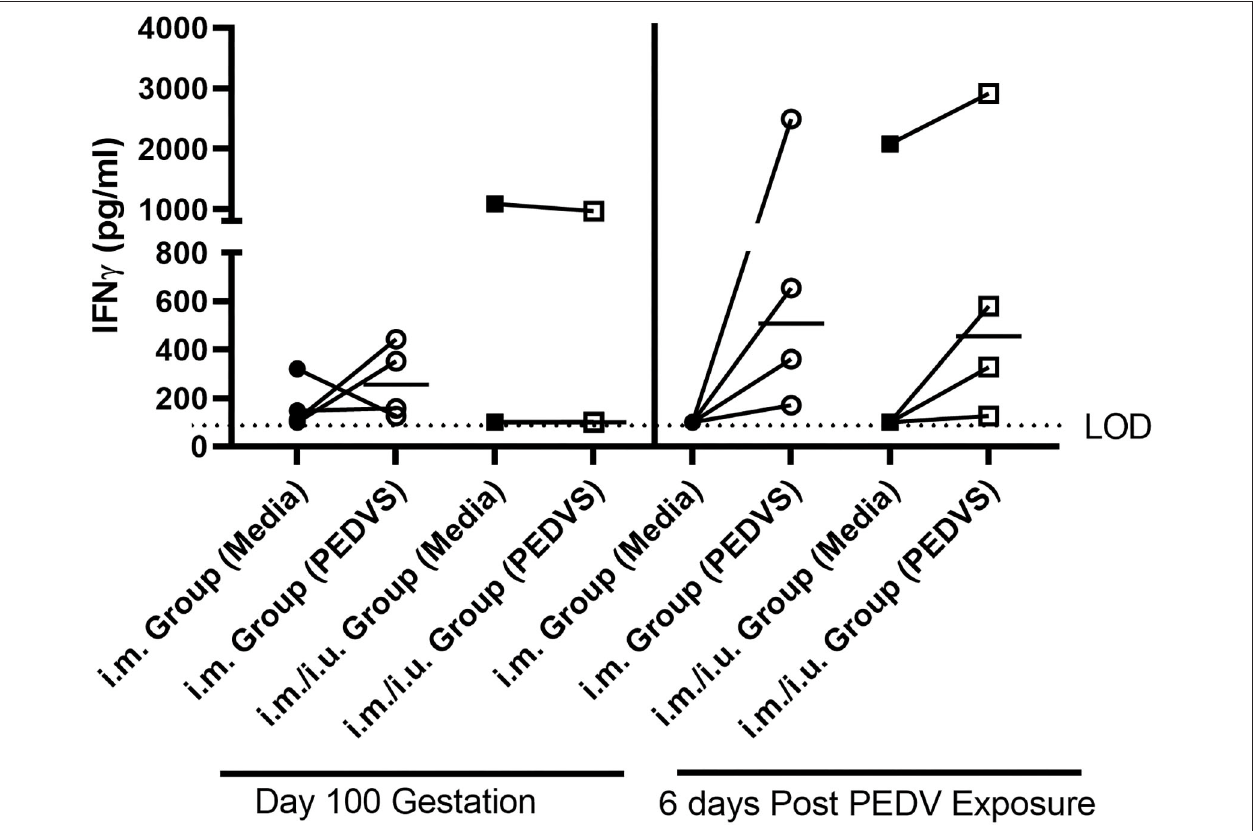
FIGURE 2 | Cell-mediated immune responses quantified by gilts vaccinated with a single i.m vaccine or a i.m vaccine primed with an i.u. vaccine at breeding. IFN γ production was established using a cytokine ELISA kit. PBMCs were isolated on day 100 gestation and on day 9 after farrowing, which is 6 days post indirect exposure to PEDV. Each symbol represents one animal. ELISAs were conducted in Immulon 2U plates and were read using the SpectraMax plus microplate reader and the limit of detection (LOD) is 100 pg/ml. Cytokine titers were graphed in GraphPad Prism 9. The median value is denoted by a horizontal bar and statistical comparisons made to unstimulated cells and cells stimulated with recombinant PEDVS1 protein using a Wilcoxon test.